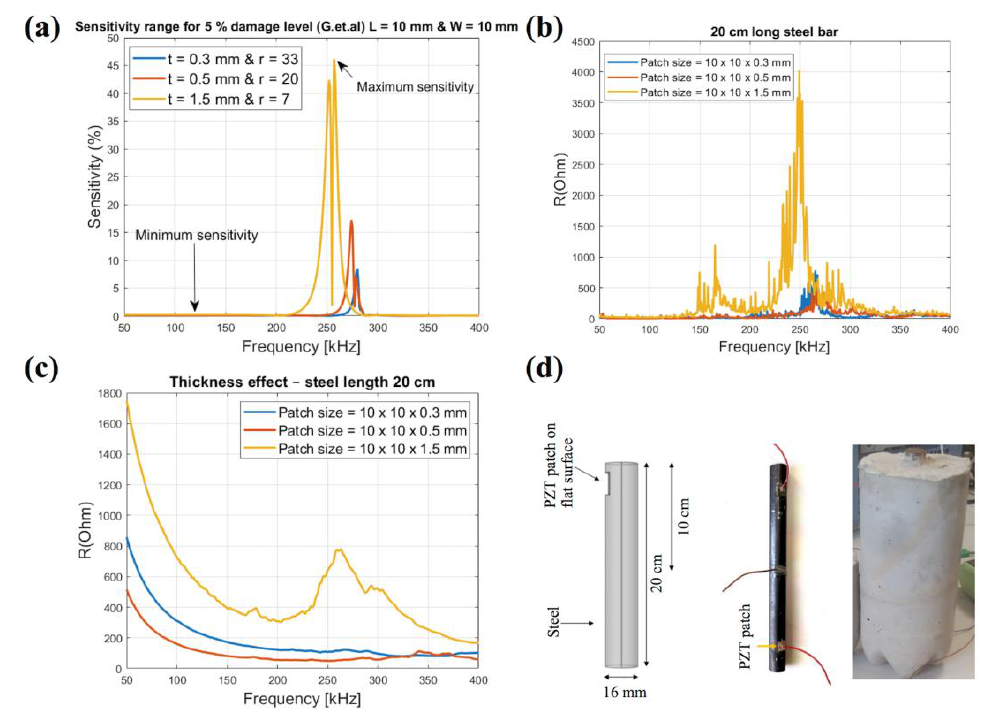
Figure 5. ( a ) Sensitivity levels with respect to thickness variations using Giurgiutiu’s model; ( b ) the real part of impedance in free air over frequency ranges from 50 to 400 kHz related to different patch size; ( c ) the real part of the impedance in reinforced concrete with varying patch thickness; ( d ) diagram of steel dimensions, actual steel, and actual concrete used in the experiments [74].